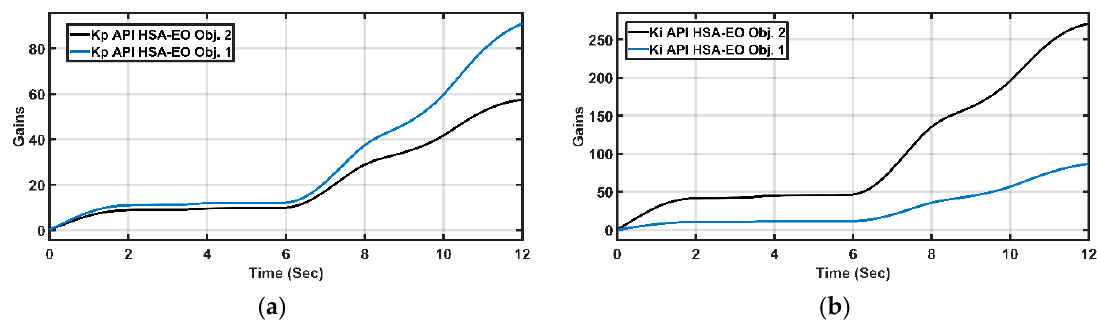
Figure 25. ( a ) Active power responses of faulty first case. ( b ) Blade-angle responses of faulty first case. The numerical comparisons of the controllers are listed in Table 11. The two adaptive PI controllers have nearly same rising time, settling time, positive peak, and negative peak. Table 12 shows the active power statistical analysis of each controller.